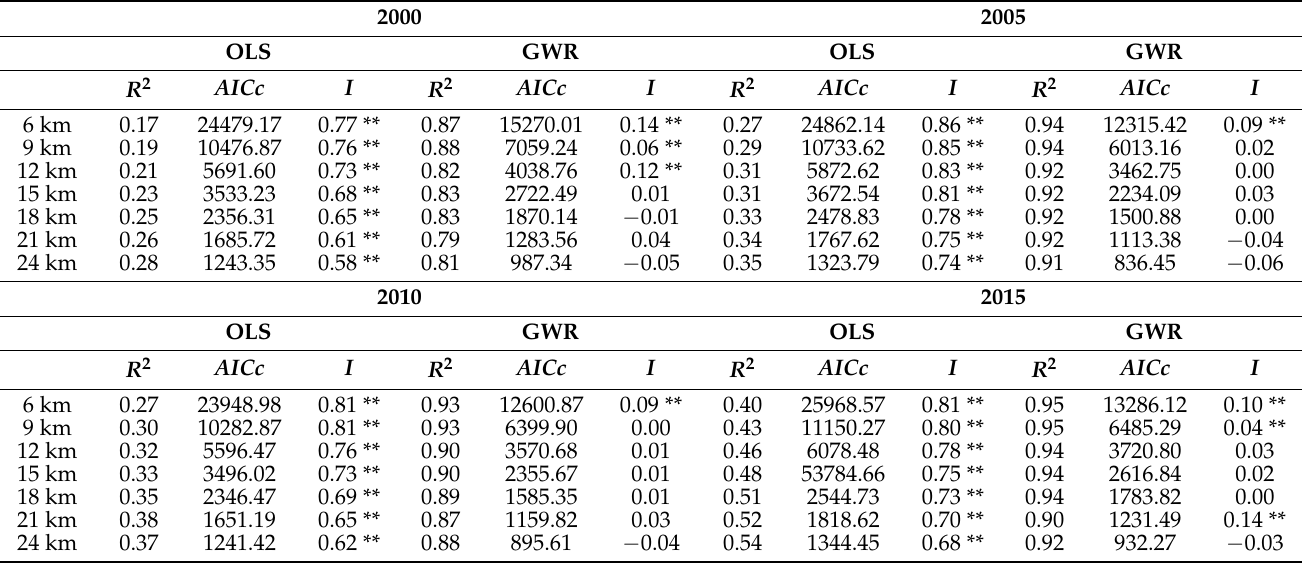
Table 3. Comparison of ordinary least squares (OLS) regression and geographically weighted regression (GWR) for the built-up density and LST across different grid sizes and periods: Summary of the coefficients and diagnostics. R 2 is the adjust coefficient of determination, AICc is the corrected Akaike Information Criterion, and I is the global Moran’s I of the standard residuals (** p < 0.01